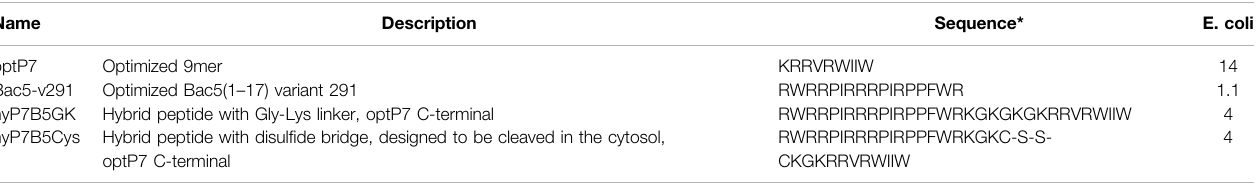
TABLE 2 | Minimum inhibitory concentrations (MIC) in µM. Data are for n (cid:2) 3 with modal values reported; all values determined in Mueller-Hinton broth (MHb) using 1 × 10 8 CFU/ml bacteria; * All peptides are C-terminal